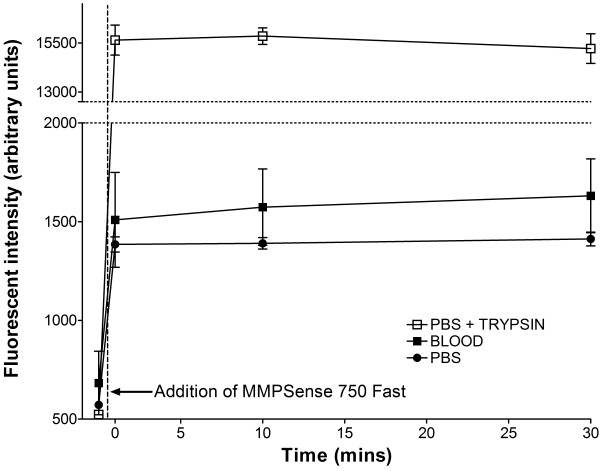
Effect of MMPSense750 cleavagein vitro. Addition of 5 μl MMPSense750 to 95 μl blood from animals following stroke produced no significant additional increase in intensity when compared to its addition to a control solution of phosphate buffer-(PBS). In contrast, the addition of MMPSense750 to a solution of 45 μl PBS + 50 μl trypsin resulted in a marked increase in fluorescent intensity (P <0.001, 2 way ANOVA).